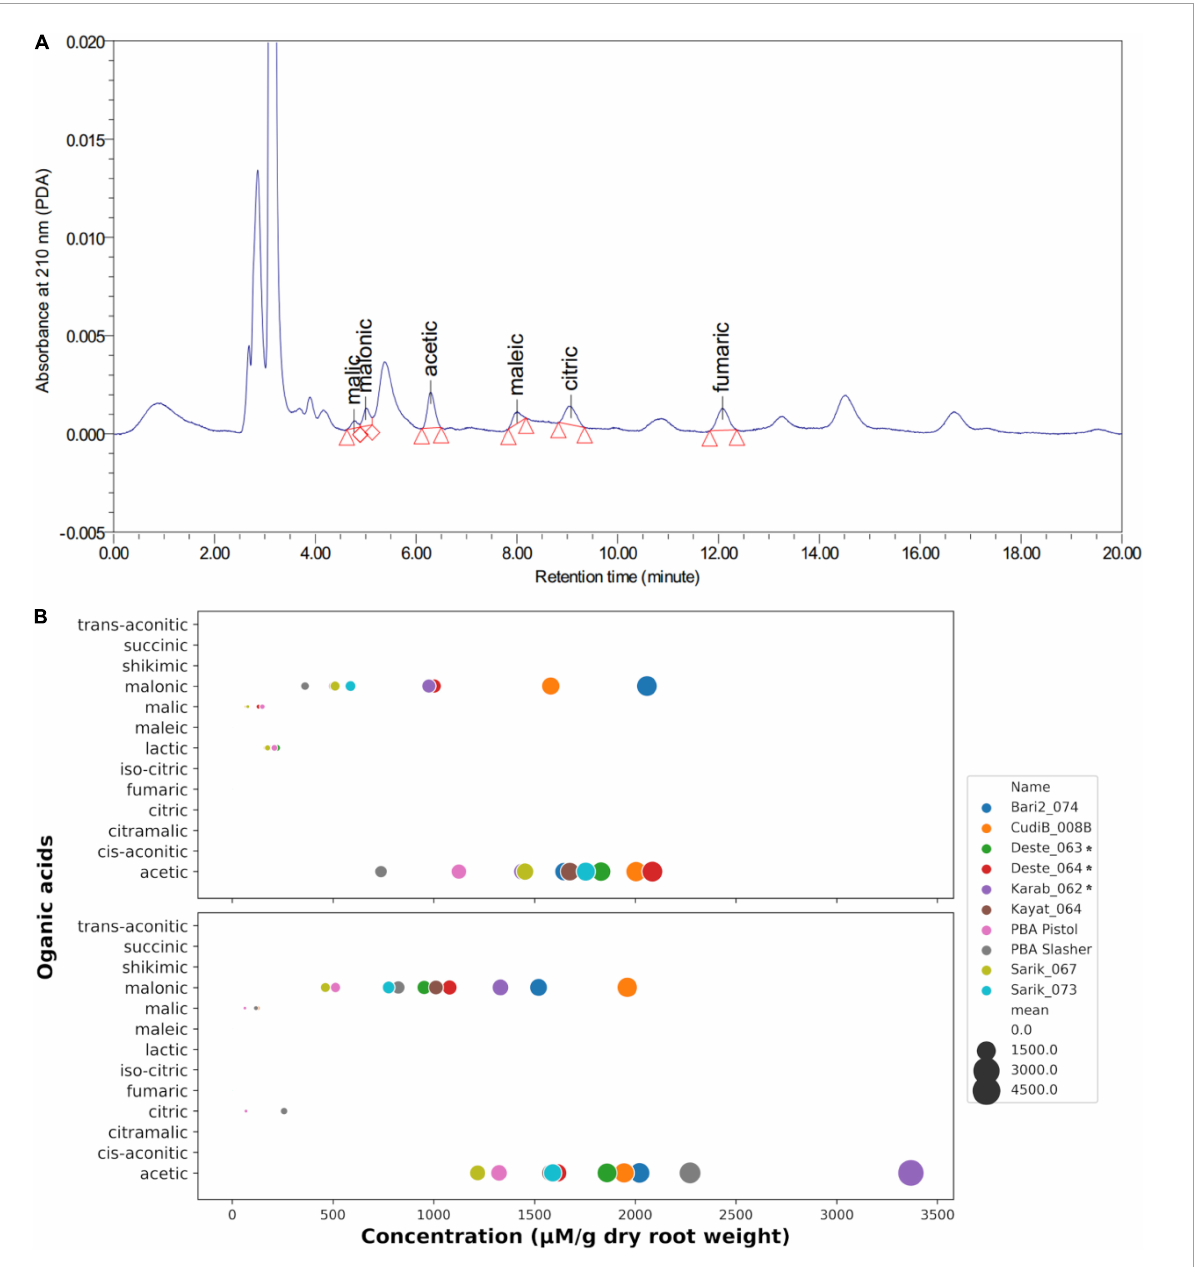
FIGURE6 Determination of organic acids secreted by chickpea root tips. (A) A representative HPLC chromatography of organic acid (OA) measurement. (B) Quantification of the OA extrusion profiles in 10 target chickpea lines in control (upper panel) and Al treatment (lower panel).